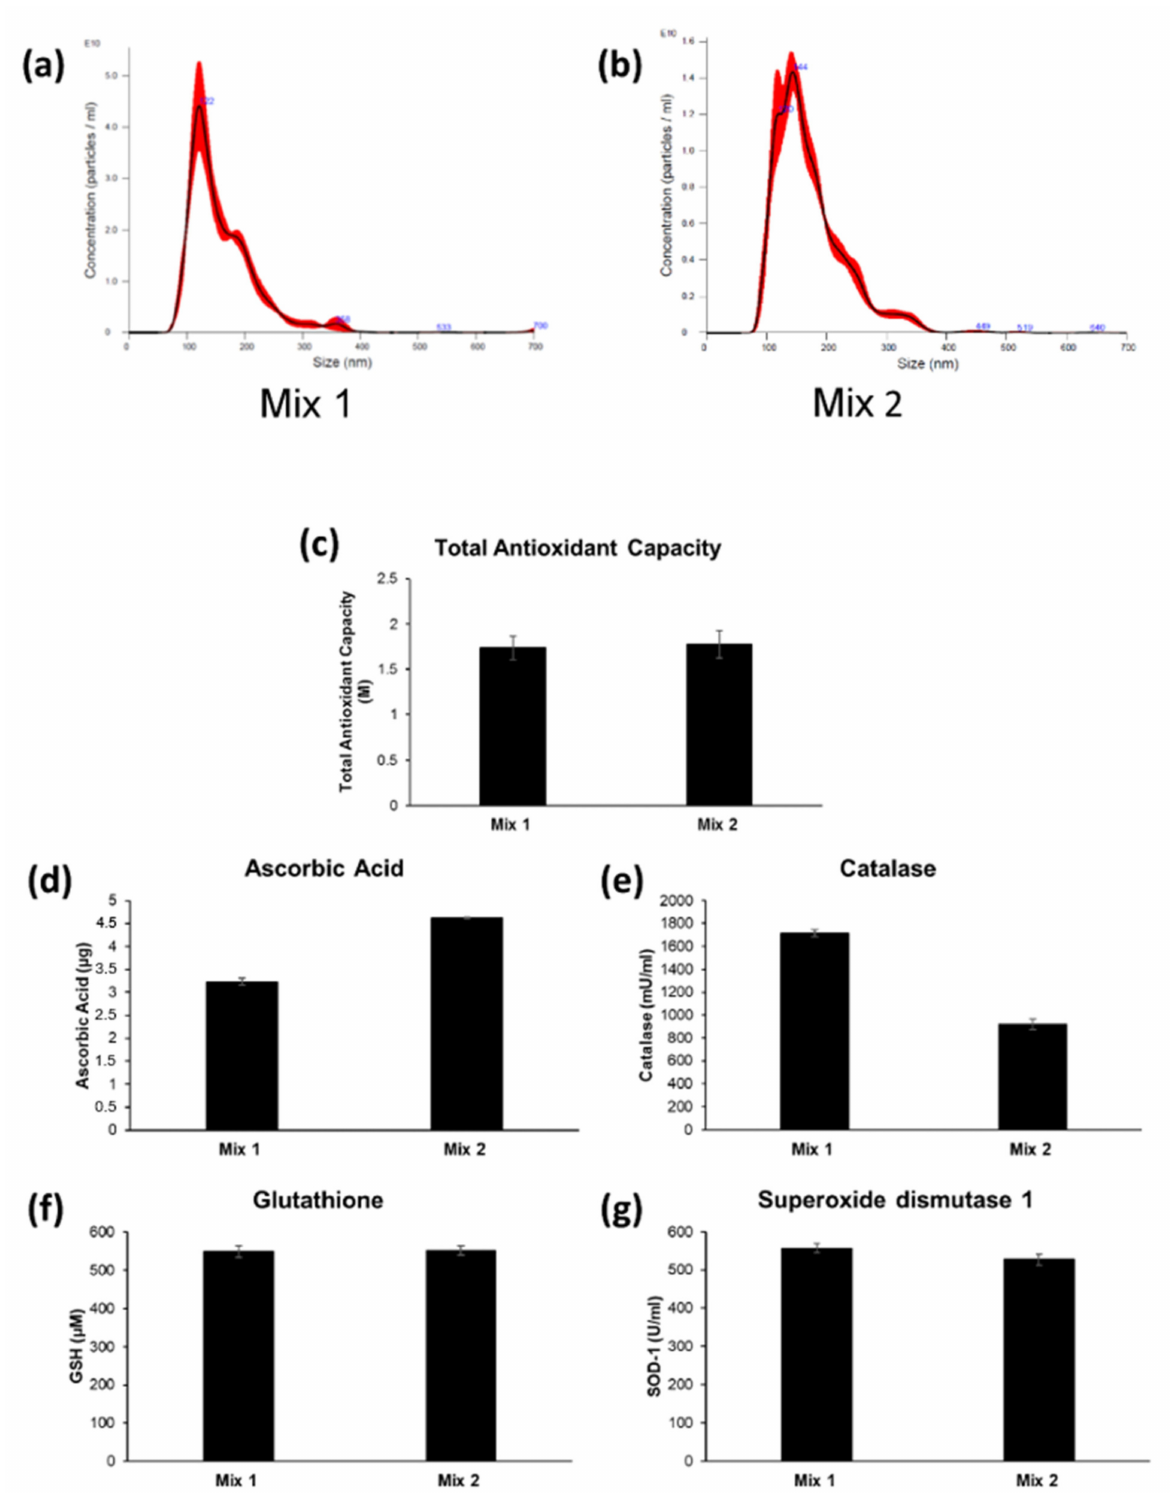
Figure 4. Characterization of antioxidants in organic-derived nanovesicles: ( a ) distribution of the nanovesicles isolated from Mix 1 analyzed through NTA; ( b ) distribution of the nanovesicles isolated from Mix 2 analyzed through NTA; ( c ) quantification of the Total Antioxidant Capacity in nanovesicles isolated from Mix 1 and Mix 2; ( d ) quantification of the Ascorbic Acid in nanovesicles isolated from Mix 1 and Mix 2; ( e ) quantification of the Catalase activity in nanovesicles isolated from Mix 1 and Mix 2; ( f ) quantification of the Glutathione in nanovesicles isolated from Mix 1 and Mix 2; ( g ) quantification of the Superoxide Dismutase 1 activity in nanovesicles isolated from Mix 1 and Mix 2. Data are expressed as the mean ±